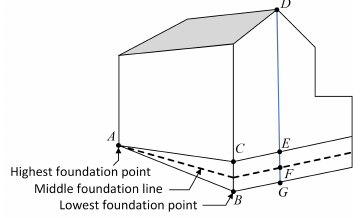
Figure 3. The rule of measuring building